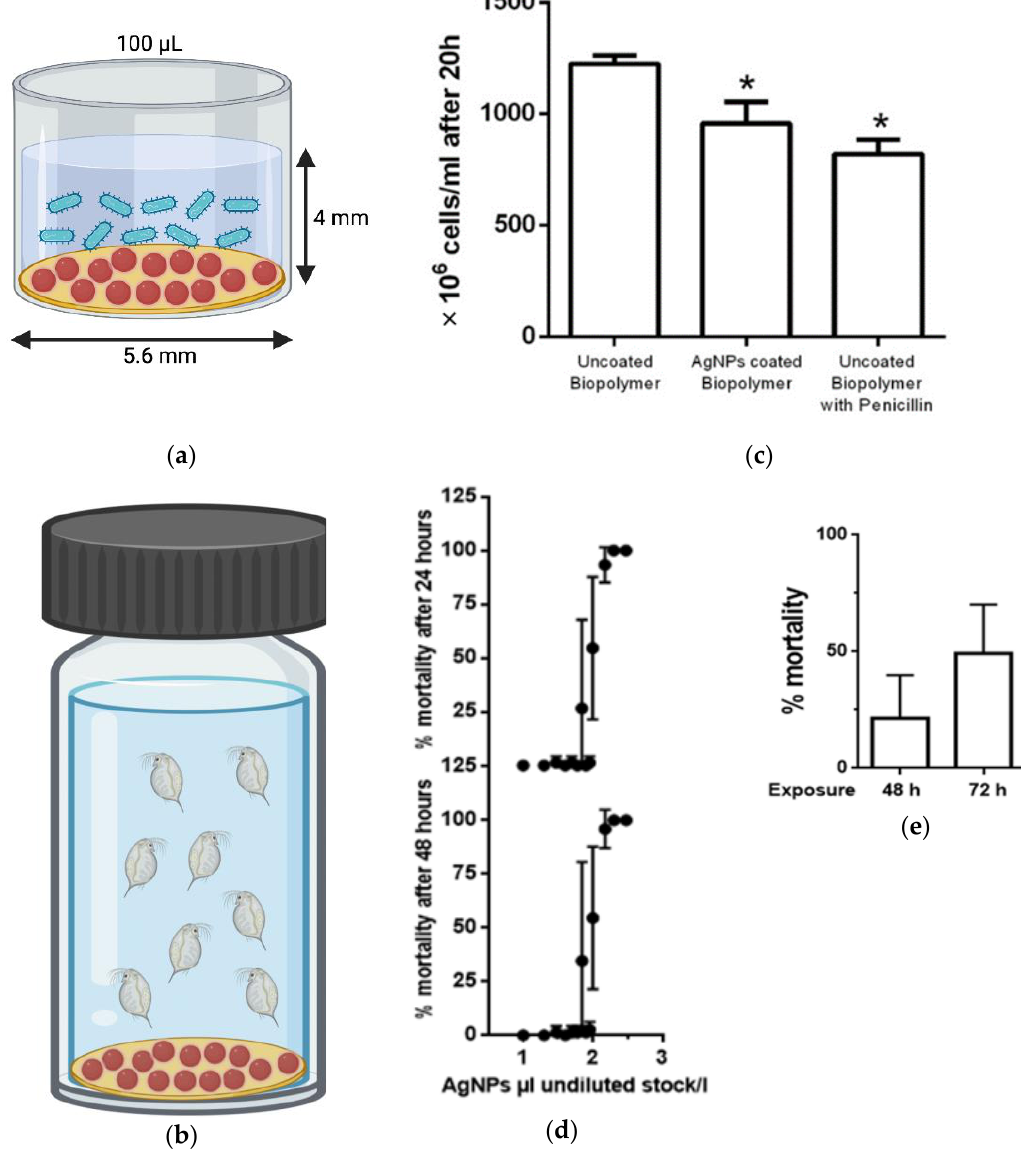
Figure 9. Characteristic of the experimental well used in the testing of antibacterial ( a ) and ecotoxicity ( b ) analysis including AgNPs-coated COP and organisms in suspension. ( c ) Impact of silver nano-ink printed cyclo-olefin polymer on bacterial growth. Data represent average ± SD ( n = 4) and considered statistically significant (*) compared with uncoated polymer by Student’s t -test ( p < 0.05). Mortality of daphniids upon exposure to silver nanoparticles in ( d ) suspension and ( e ) on silver nano-ink-coated cyclo-olefin polymer. Data represent average ± SD (N = 5).